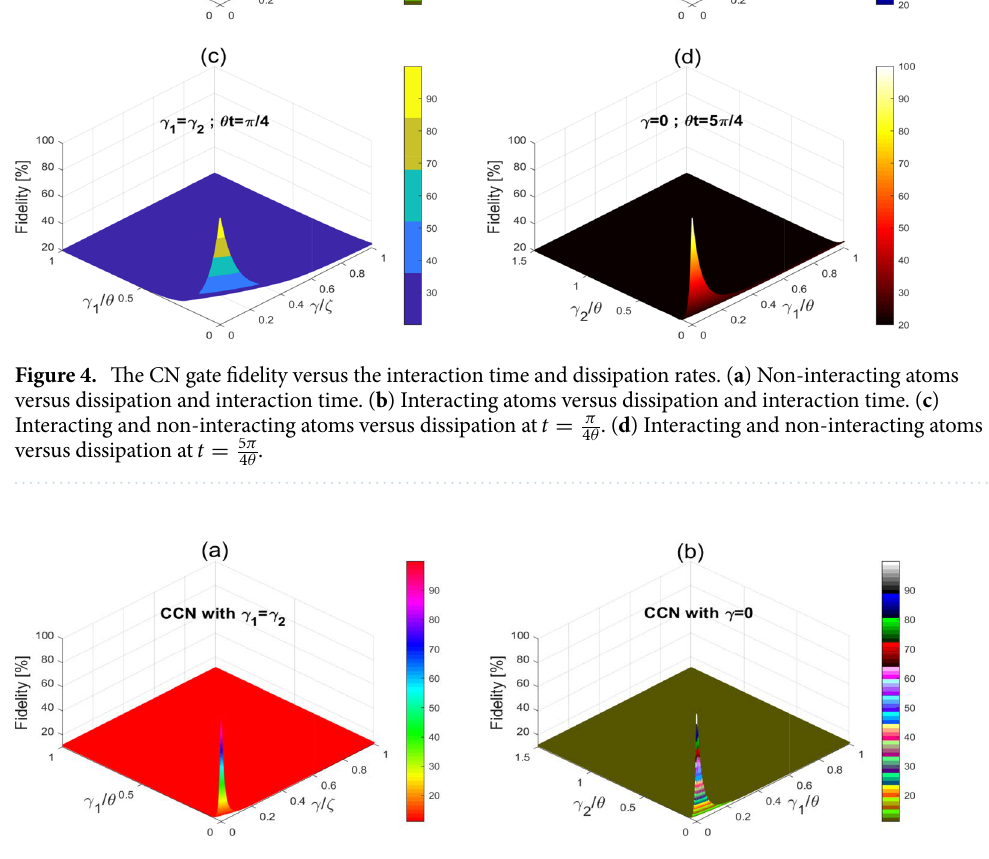
Figure 5. The CCN gate fidelity against